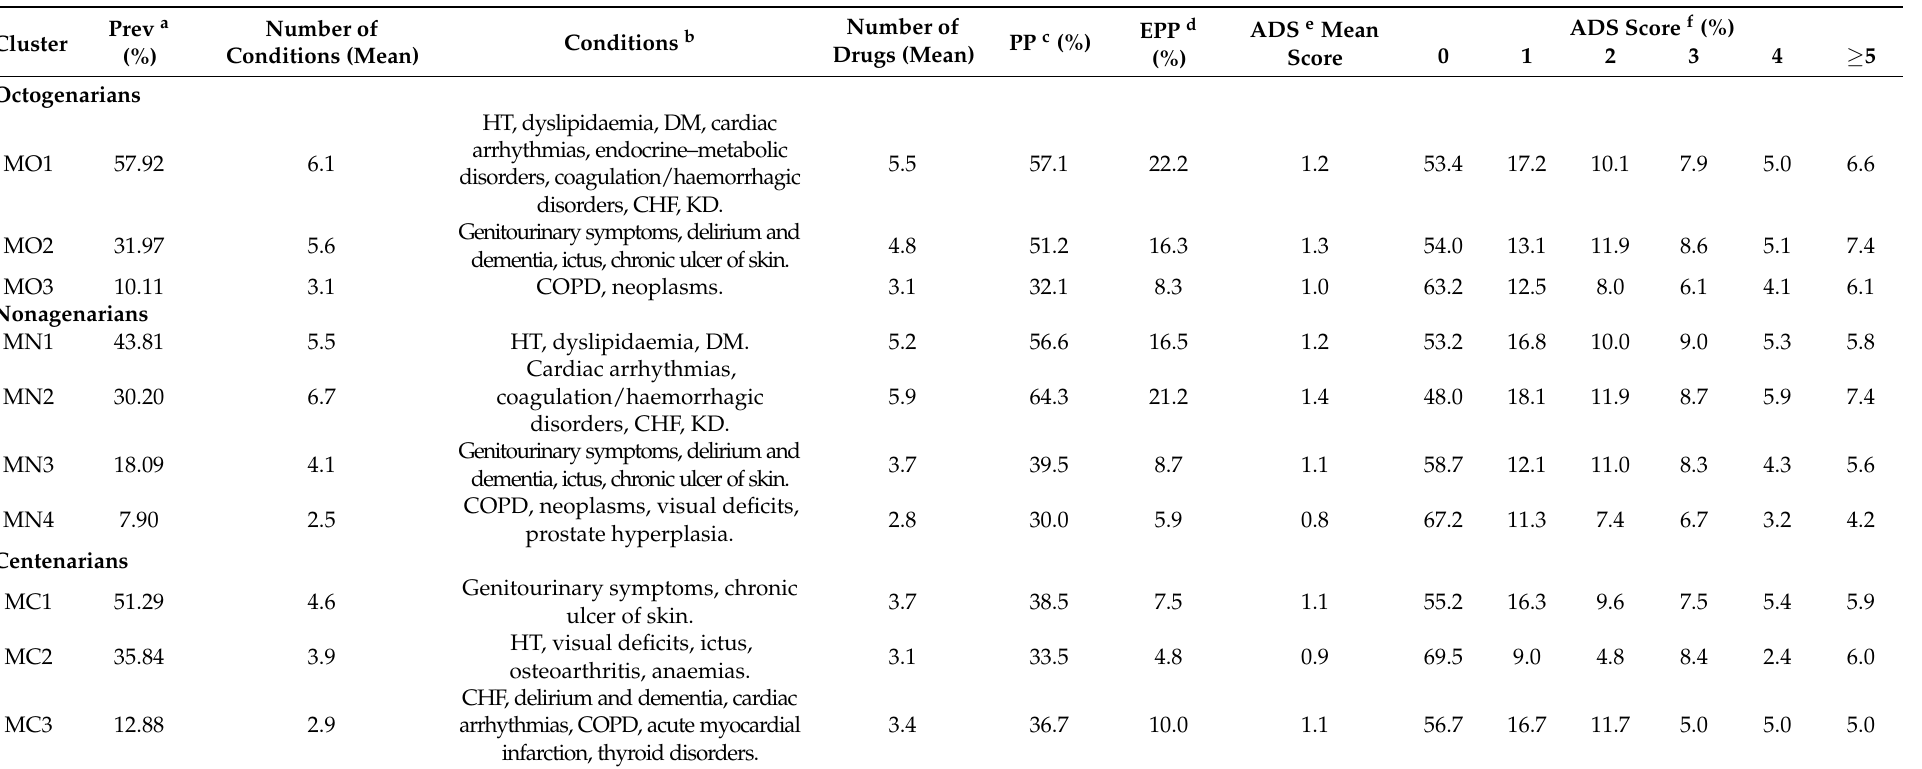
Table 2. Multimorbidity clusters in oldest old men by age group (octogenarians, MO1, MO2, and MO3; nonagenarians, MN1, MN2, and MN3, and MN4; centenarians, MC1, MC2, and